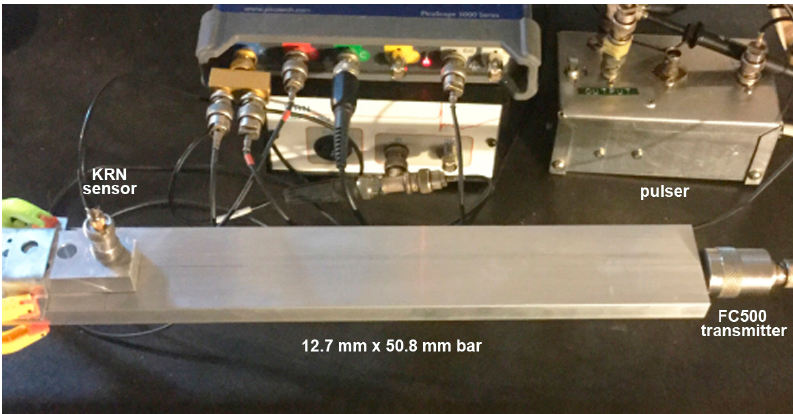
Figure A2. Photographs of a bar-wave calibration set-up. Bar size was 12.7 mm × 50.8 mm × 1220 mm. AET FC500 transmitter is glued on end face and a KRN sensor is positioned at 300 mm.